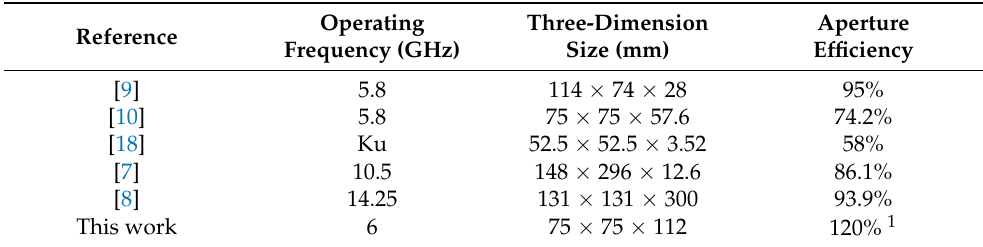
Table 2. Comparison of two dimension aperture efficiency between the proposed array with other aperture